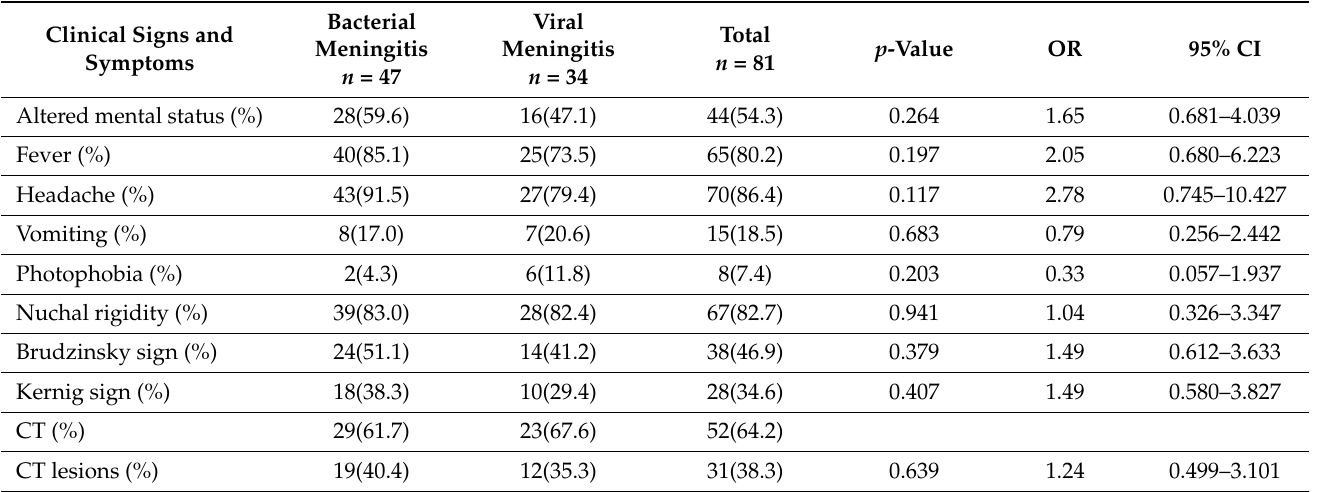
Table 3. Clinical signs and